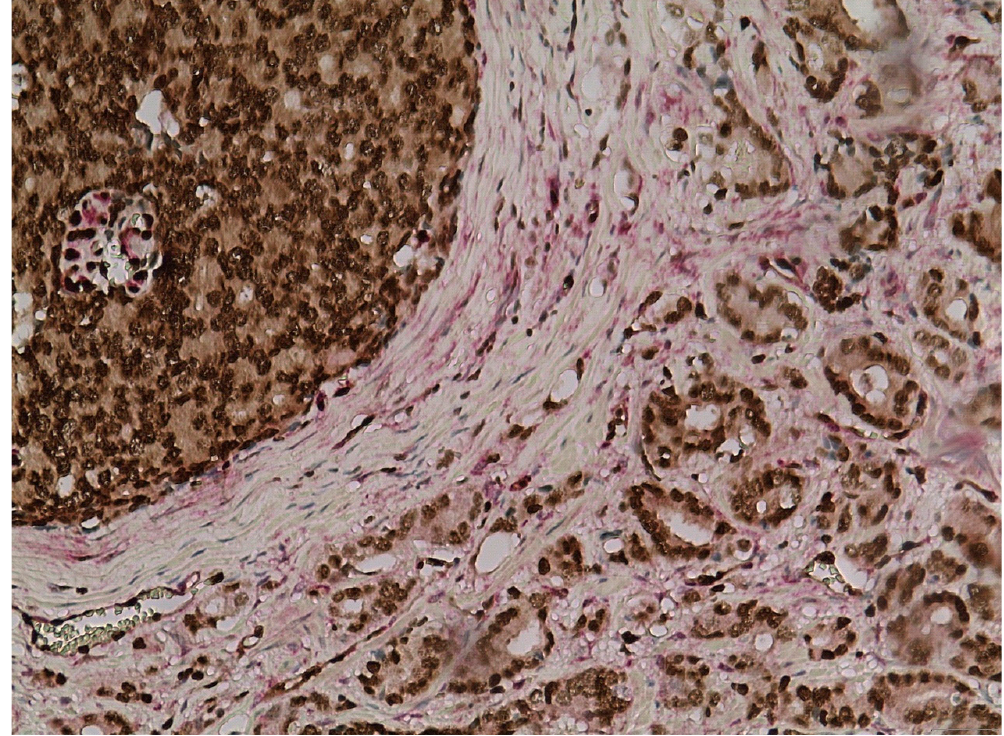
Figure 9. Simultaneous ERG nuclear immunopositivity in intraductal carcinoma and in adjacent low-grade invasive carcinoma (×200).